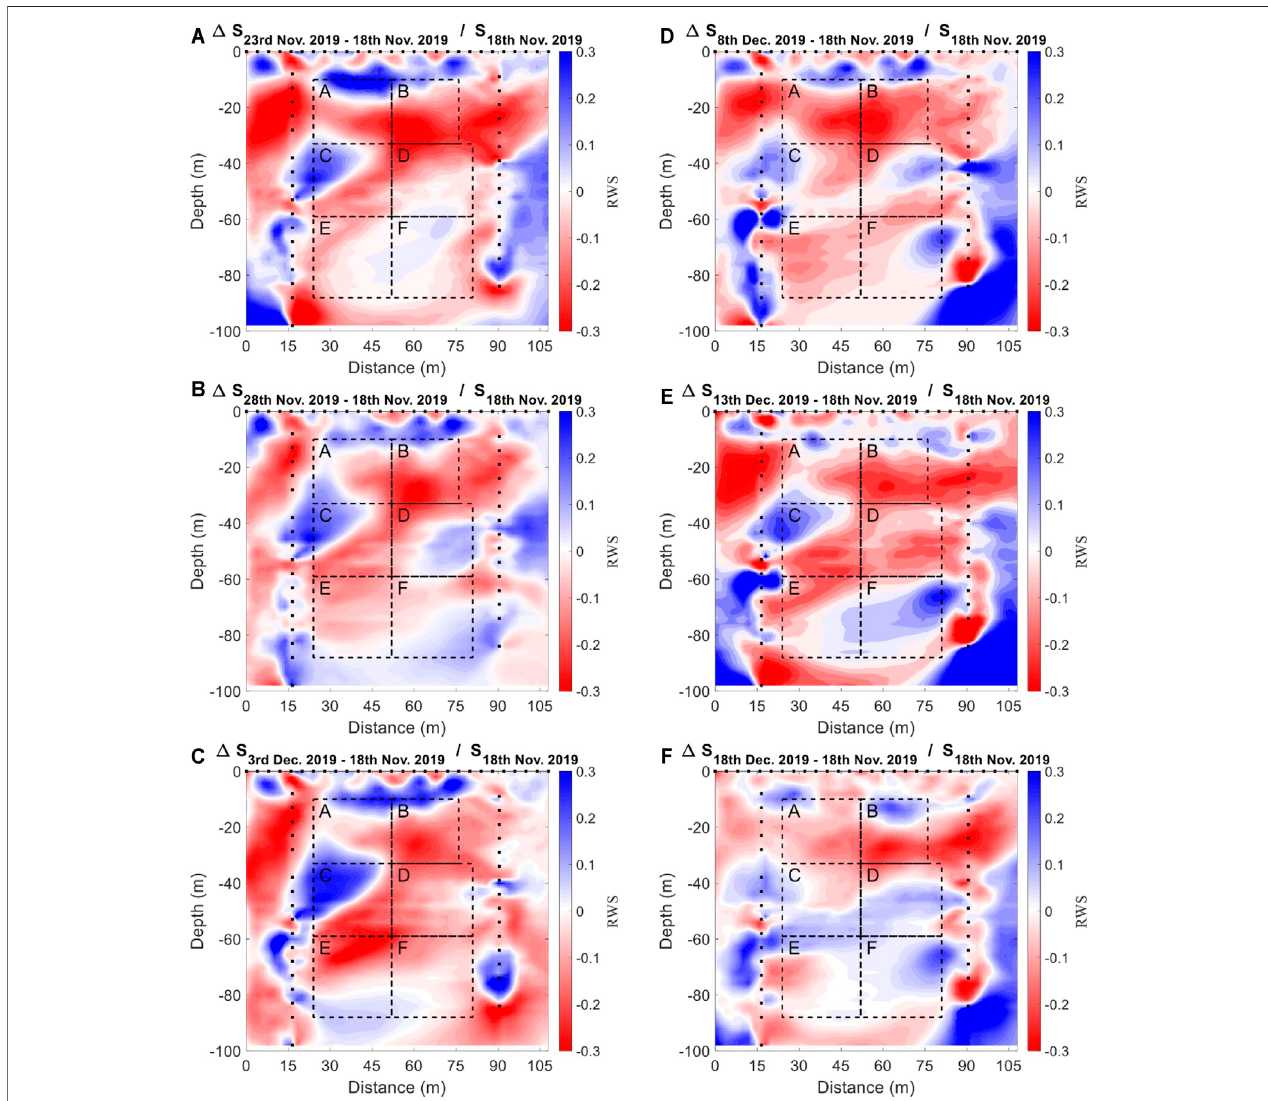
FIGURE 9 | Cross-section of the relative water saturation (RWS) for the long-duration precipitation event based on the map for November 18, 2019, after (A) 5 days, (B) 10 days, (C) 15 days, (D) 20 days, (E) 25 days, and (F) 30 days. Blue shows increasing RWS estimated from the decreases in the electrical resistivities, whereas red shows decreasing RWS because of the resistivity